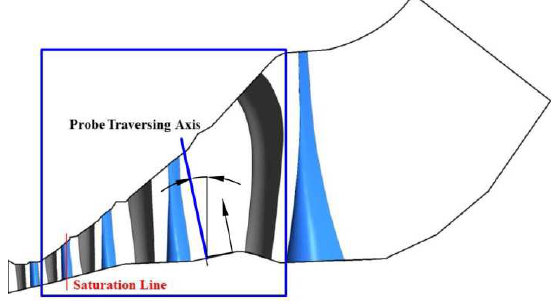
Fig. 2 . The placement of the probe in the LP turbine .